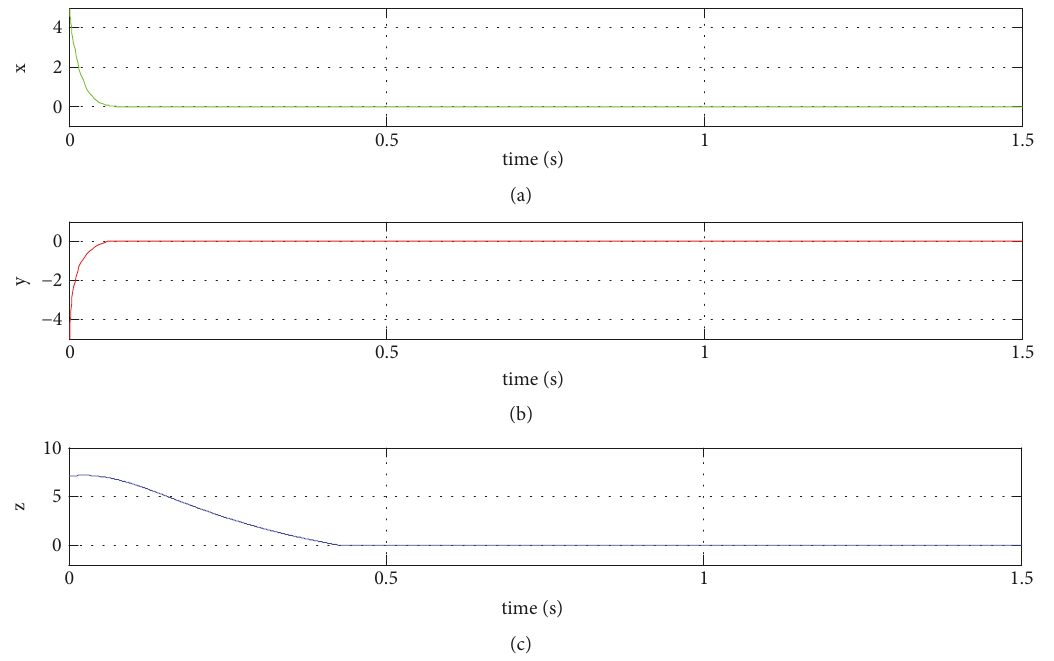
Figure 7: Robust adaptive stabilization for: (a) state 𝑥 , (b) state 𝑦 , and (c) state